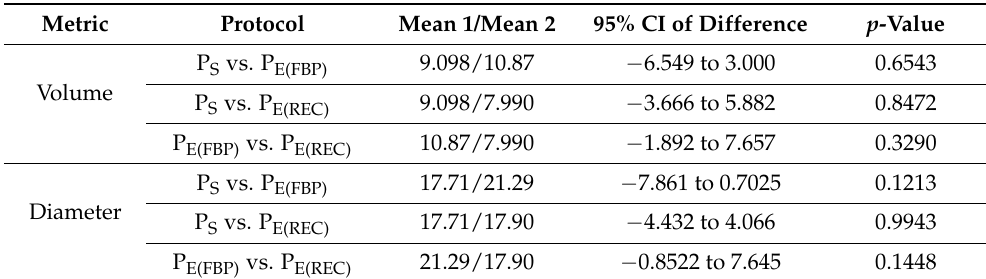
Table 2. Comparative overview of measured nodule size differences among distinct protocols. The table displays and compares the metric differences between institute-specific standard low-dose protocols (P S ) and ESTI protocols (P E ) reconstructed with filtered back projection (P E(FBP) ) as well as with iterative reconstruction (P E(REC) ). CI: Confidence Interval.